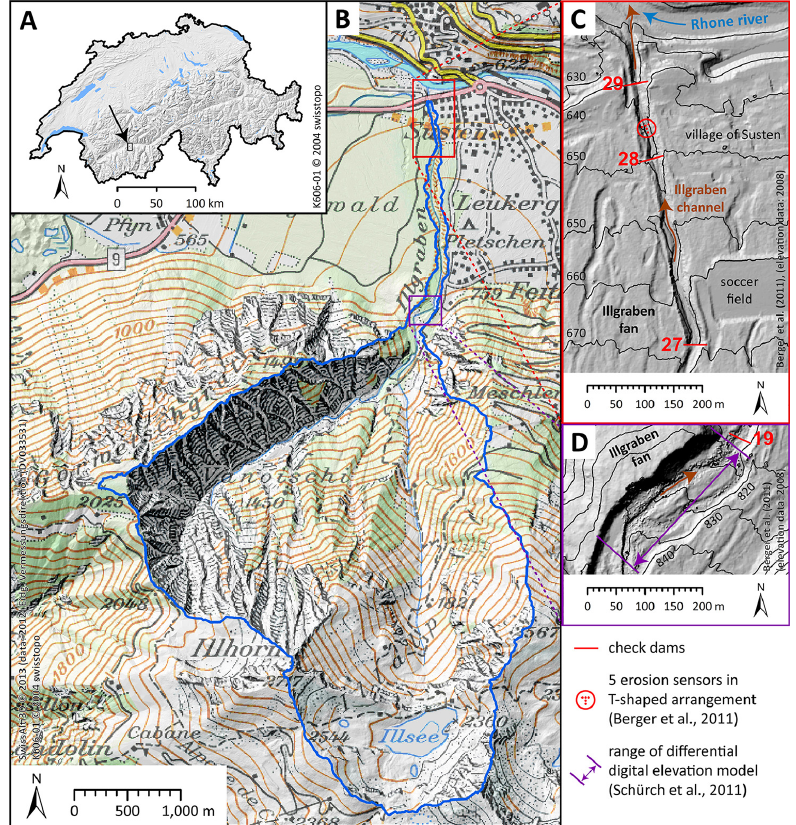
Figure 1. (a) The Illgraben catchment in southern Switzerland. (b) Locations of the instrumentation site and data available for the erosion analysis at the Illgraben catchment. (c) On the lower fan of Illgraben, the location of the erosion sensors (Berger et al., 2011) and main instrumentation site (McArdell et al., 2007) on check dam 29 is shown. (d) The channel reach covered by the terrestrial laser scanning-based elevation-change analysis (Schürch et al., 2011b) is located on the upper fan below the fan